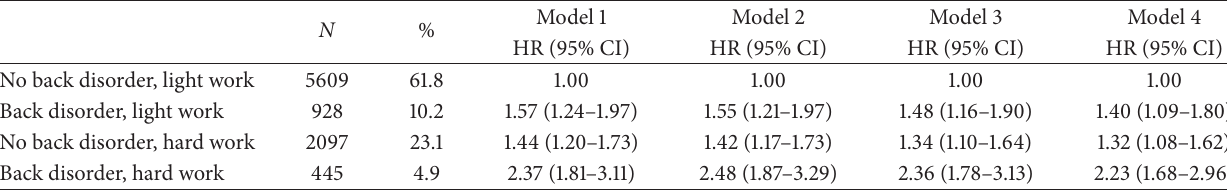
Table 3: The prospective associations between physician-diagnosed back disorder, physical activity at work, and risk of LTSA. Model 1 N % No back disorder, light